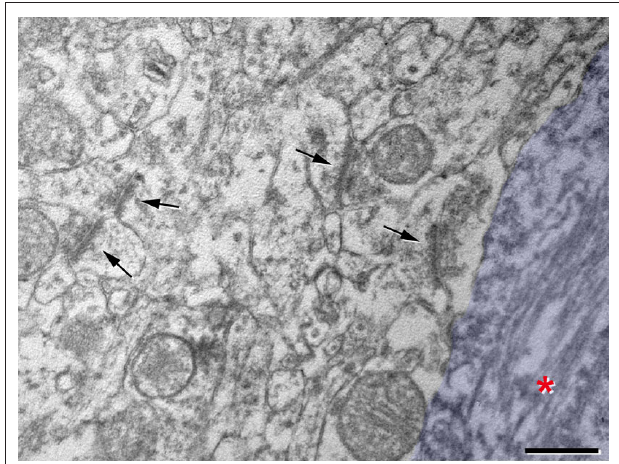
FiGure 15 | High magnification electron micrograph illustrating the neuropil around the PHF-tau-ir cell 7 also shown in Figure 14, where the soma has been pseudo-colored in blue. Asterisk, paired helical filaments stained for PHF-tau. Arrows indicate some synaptic contacts in the neuropil. Scale bar: 0.5